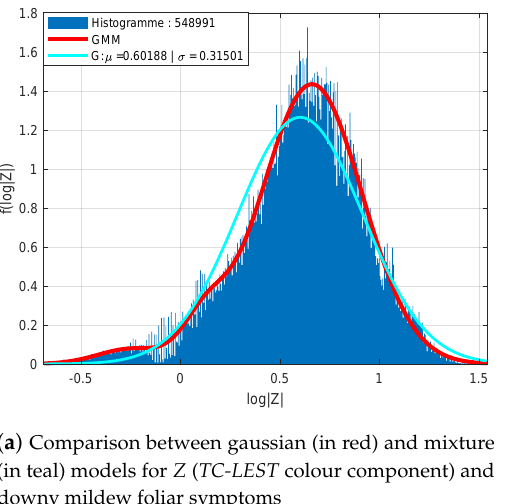
Figure 7. Adequacy of the distribution of log-determinants of Z ( TC-LEST colour component) (red) and comparison with Gaussian mixture (teal) for foliar downy mildew symptoms (a ). Details of the K = 3 Gaussian mixture ( b